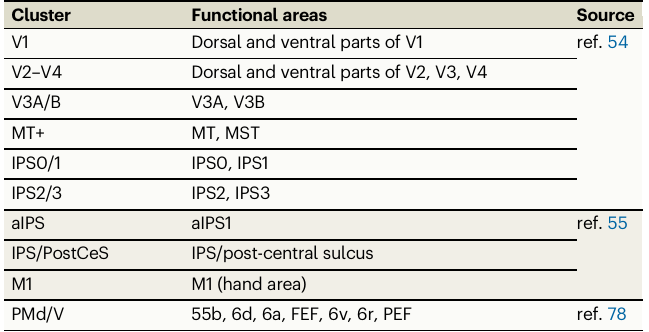
Table 1 | Region of interest de fi nition Cluster Functional areas Source